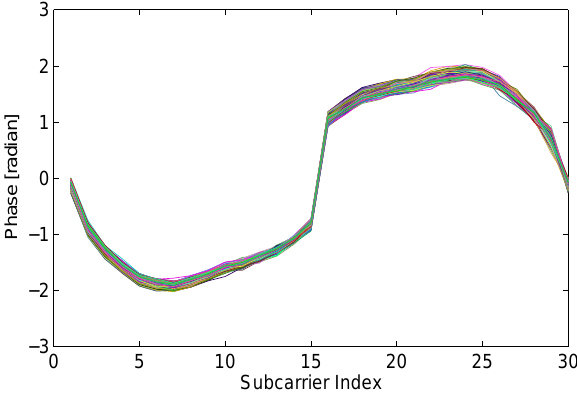
Figure 5. Phase before and after linear transformation.